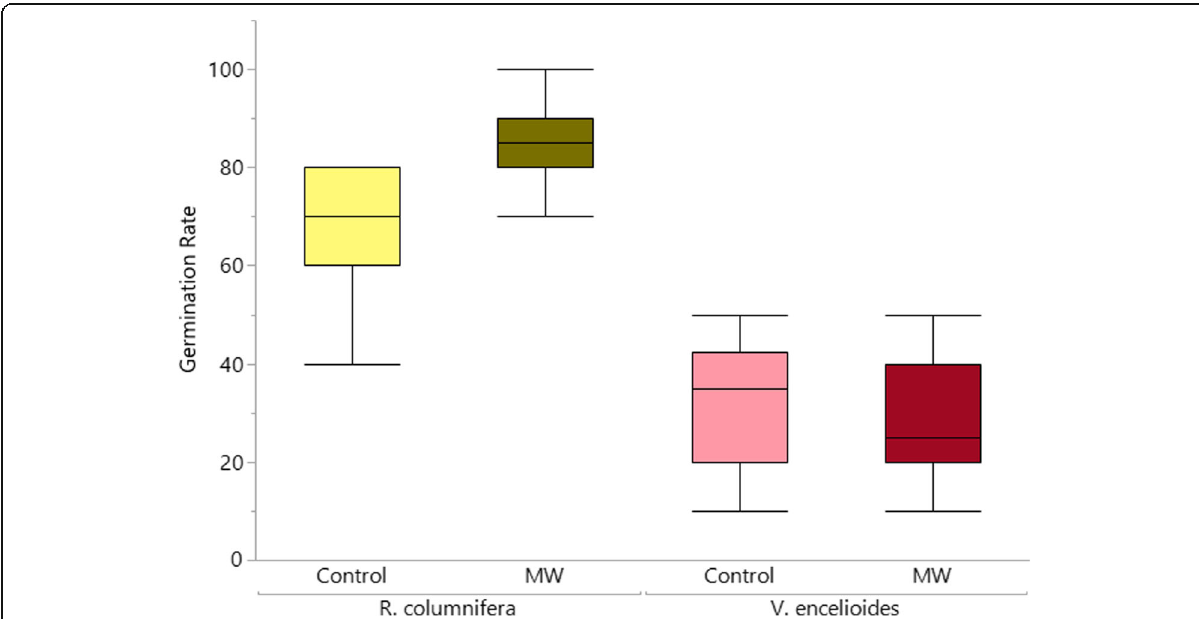
Fig. 1 The total germination rate for V. encelioides and R. columnifera seeds treated with a microbial wash (MW) and without any treatment (control) at the end 14-day period